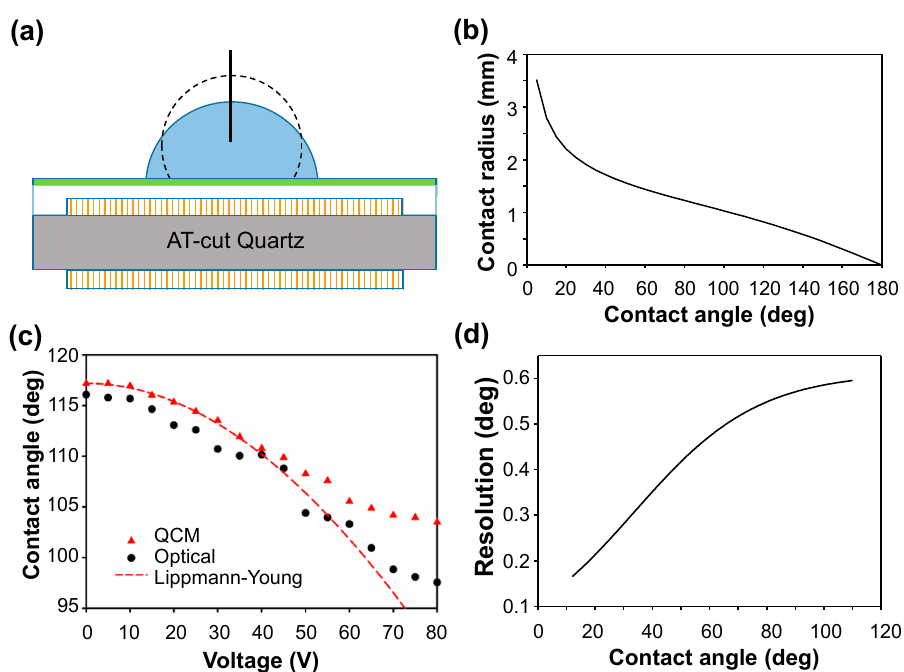
Figure 2. Measurement of the contact angle of a 3- μ L water droplet in air with a QCM. ( a ) Experimental setup. ( b ) Variation of contact radius of a 3- μ L droplet with contact angle. ( c ) Contact angle measured with a QCM and an optical goniometer when voltage 1 kHz AC was applied. ( d ) Variation of QCM resolution with contact angle.